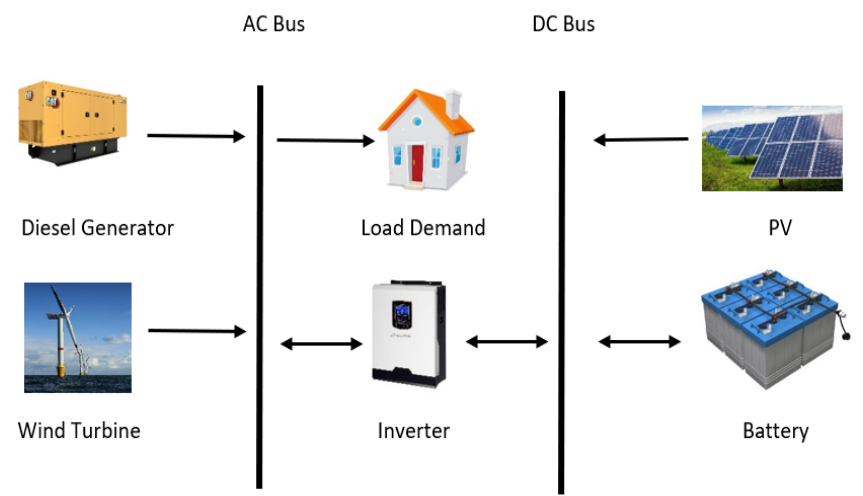
Figure 1. Proposed power system